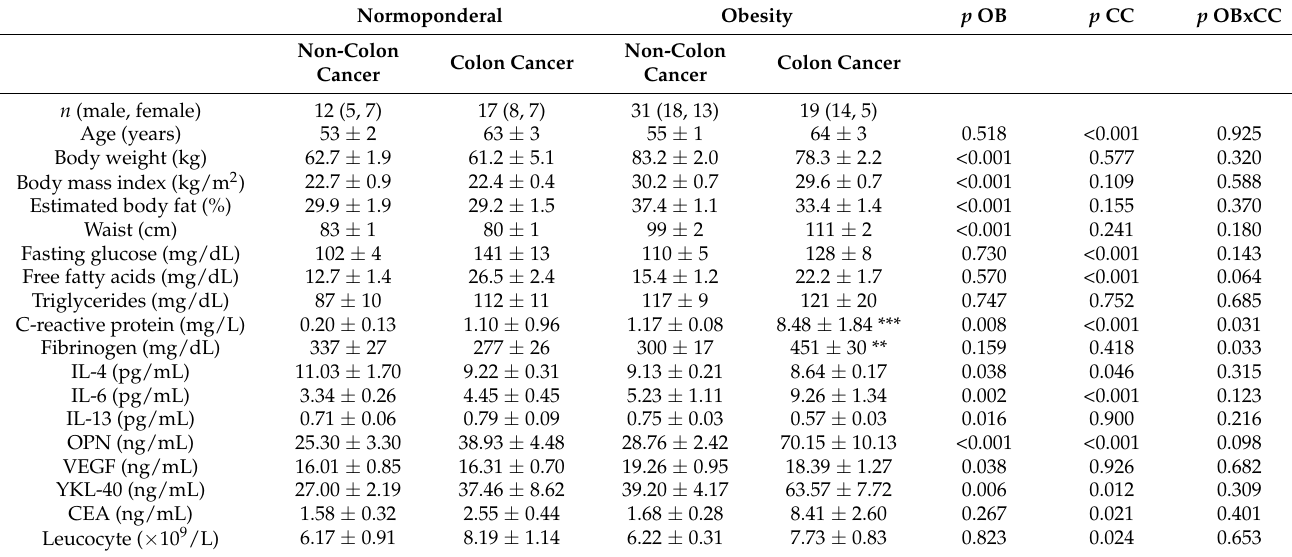
Table 1. Anthropometric and biochemical characteristics of the subjects included in the study.